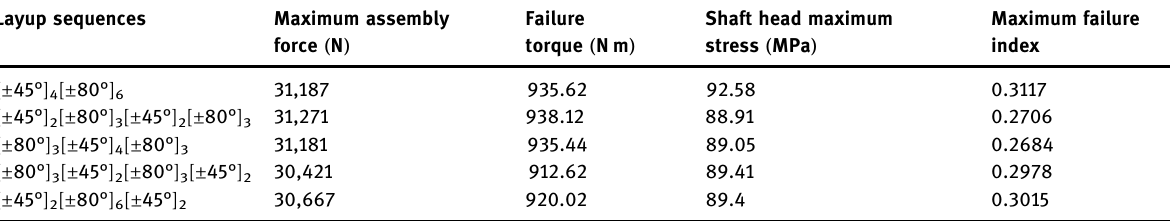
Table 5: Evaluation index of interference fi t joints at di ff erent layup sequences Layup